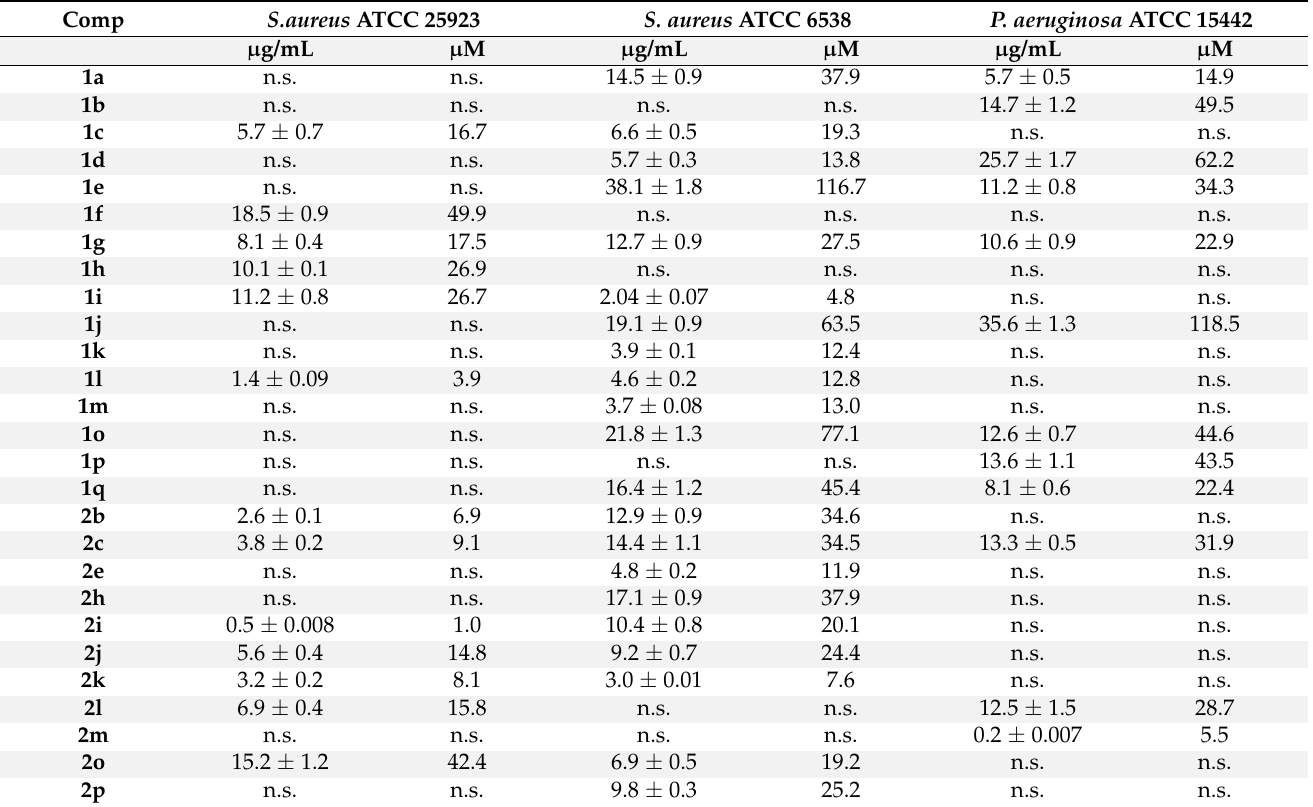
Table 3. Inhibition of biofilm formation, BIC 50 , µ g/mL and µ